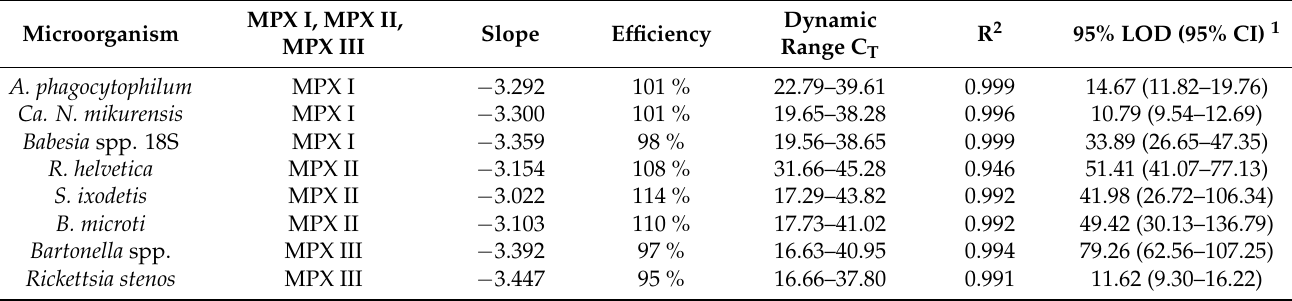
Table 3. Evaluation parameters for the three multiplex qPCR assays.